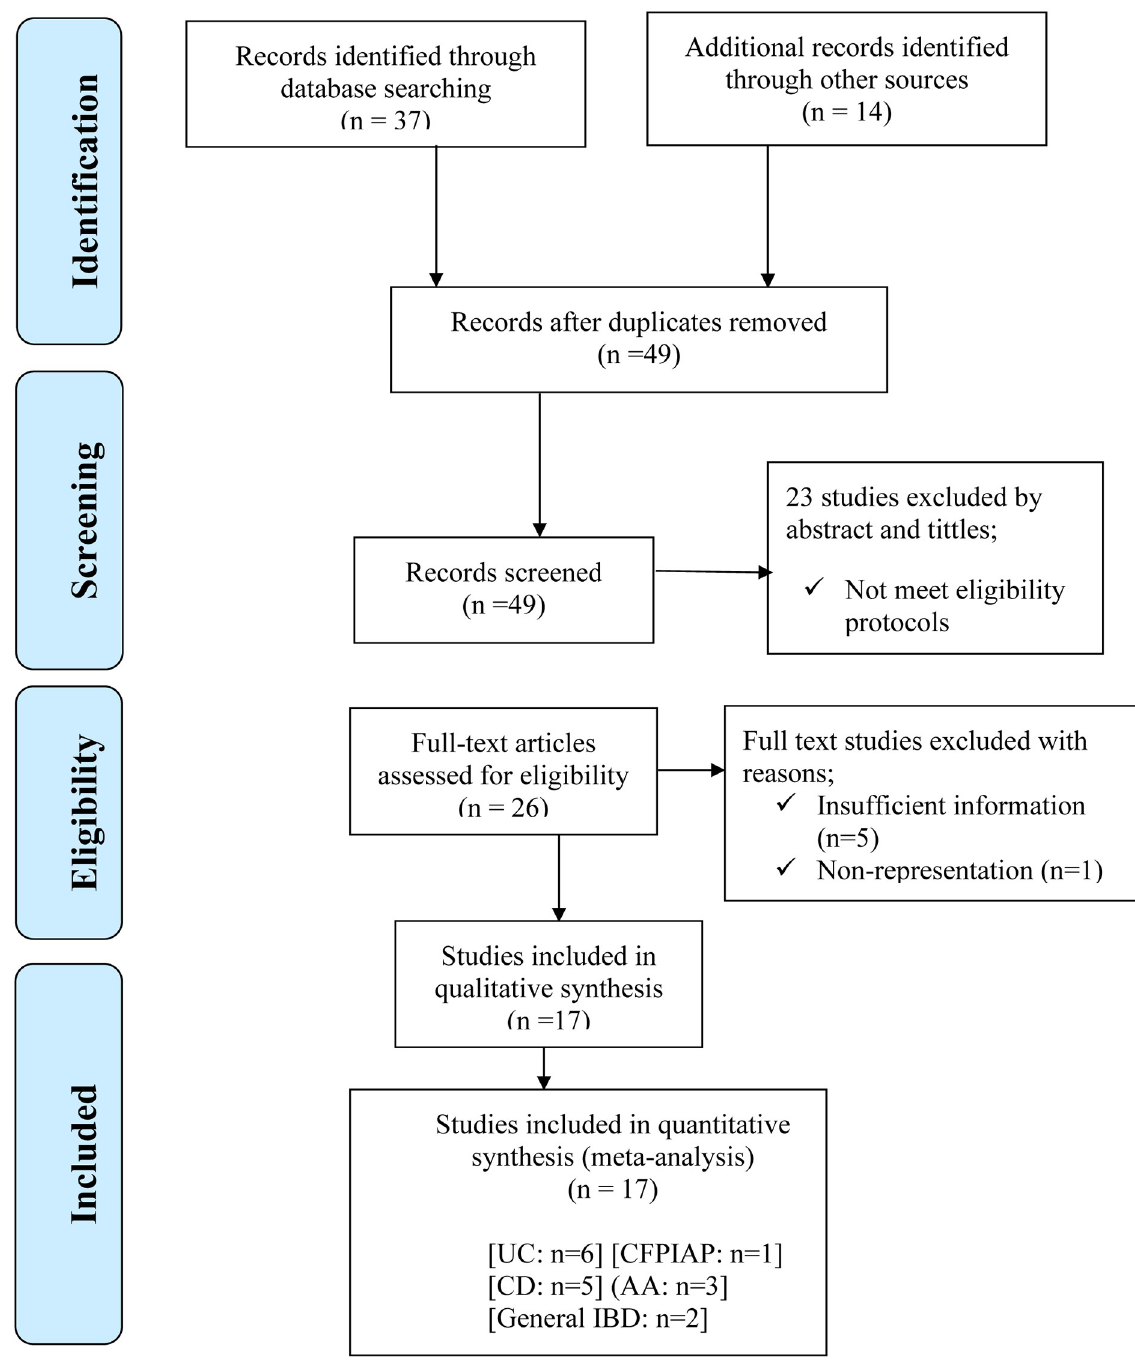
Fig 1. PRISMA flow chart describing screening protocols of studies for Meta-analysis. NB; UC: Ulcerative Colitis; CD: Crohn’s Disease; IBD: Inflammatory Bowel Disease; AA: Acute Appendicitis; CFPIAP: Child Food Protein Induced Allergic Proctocolitis.